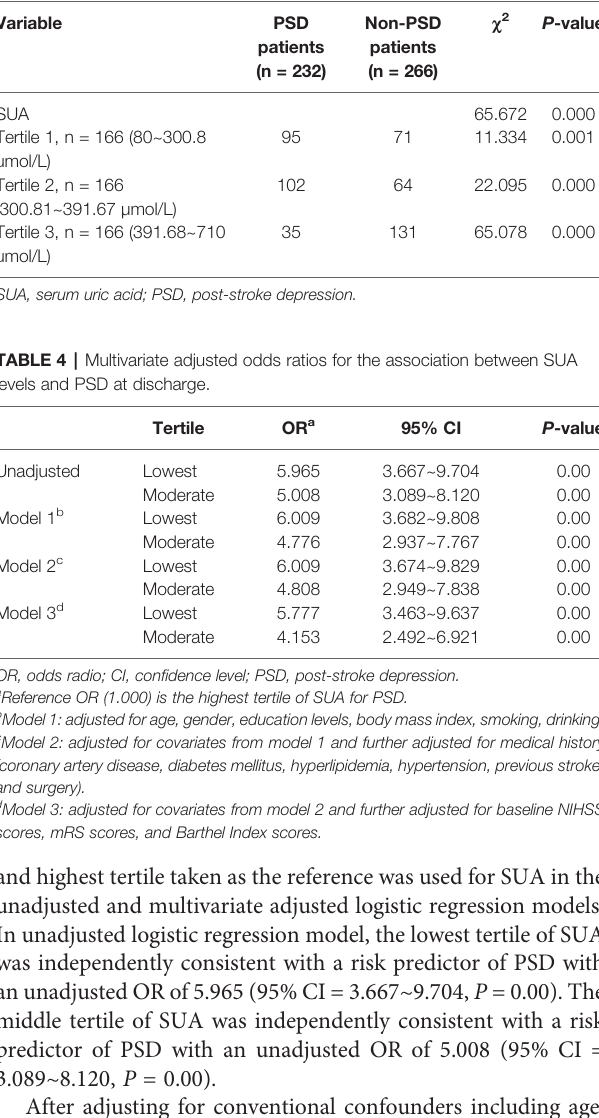
TABLE 3 | SUA tertiles of patients.